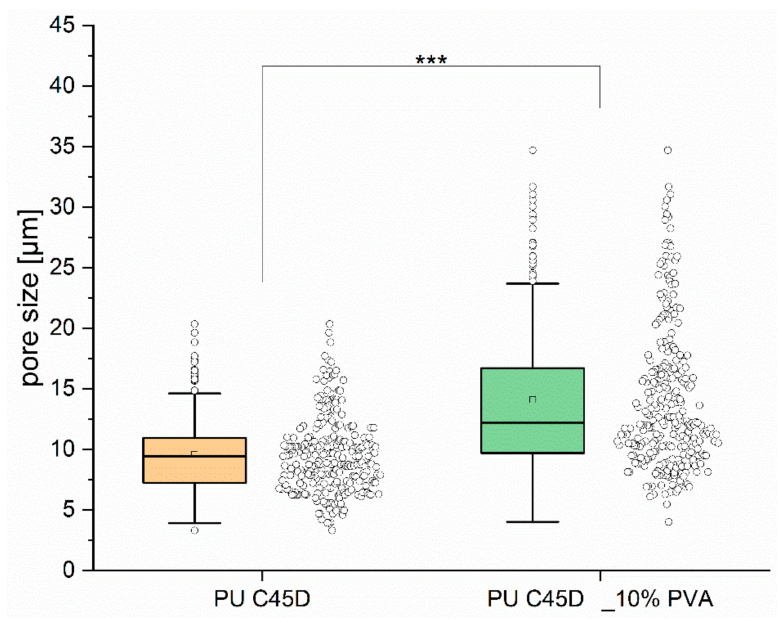
Figure 11. Pore size distribution for PU C45D and PU C45D_10% PVA, *** p <